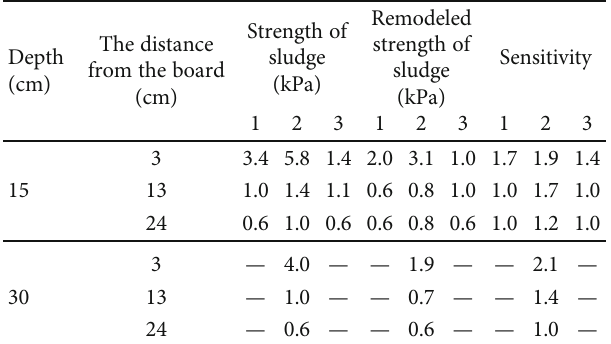
Figure 13: Vertical moisture content distribution curve. Table 5: Shear strength of